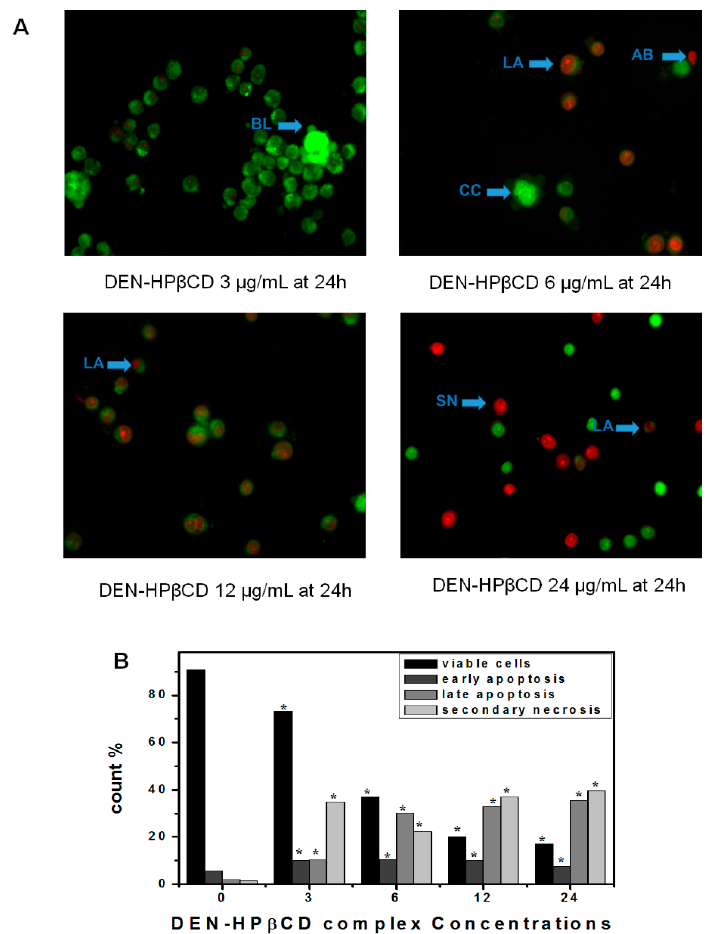
Figure 6. ( A ) Fluorescent micrographs of double-stained HT29 cells (acridine orange and propidium iodide). Untreated cells appeared normal structure without any features of apoptosis and necrosis. The early apoptosis features were seen after treatment with DEN-HP β CD complex (3 µg/mL) representing intercalated acridine orange (bright green) with fragmented DNA and Blebbing after 24 h. The hallmarks of late apoptosis which represented by orange colour were noticed after 24 h of treated with (6 µg/mL) which increased with increasing the concentration. Cells with bright red colour and big size representing secondary necrosis were visible after treated with higher concentration at 24 h. VI , viable cells; BL , blebbing of the cell membrane; CC , chromatin condensation; LA , late apoptosis; SN , secondary necrosis; AB , apoptotic bodies. Images are representative of one of the three similar experiment; ( B ) Count cells on different microphotographs. Note: the magnification is 40×. * p < 0.05 compared with untreated cells.